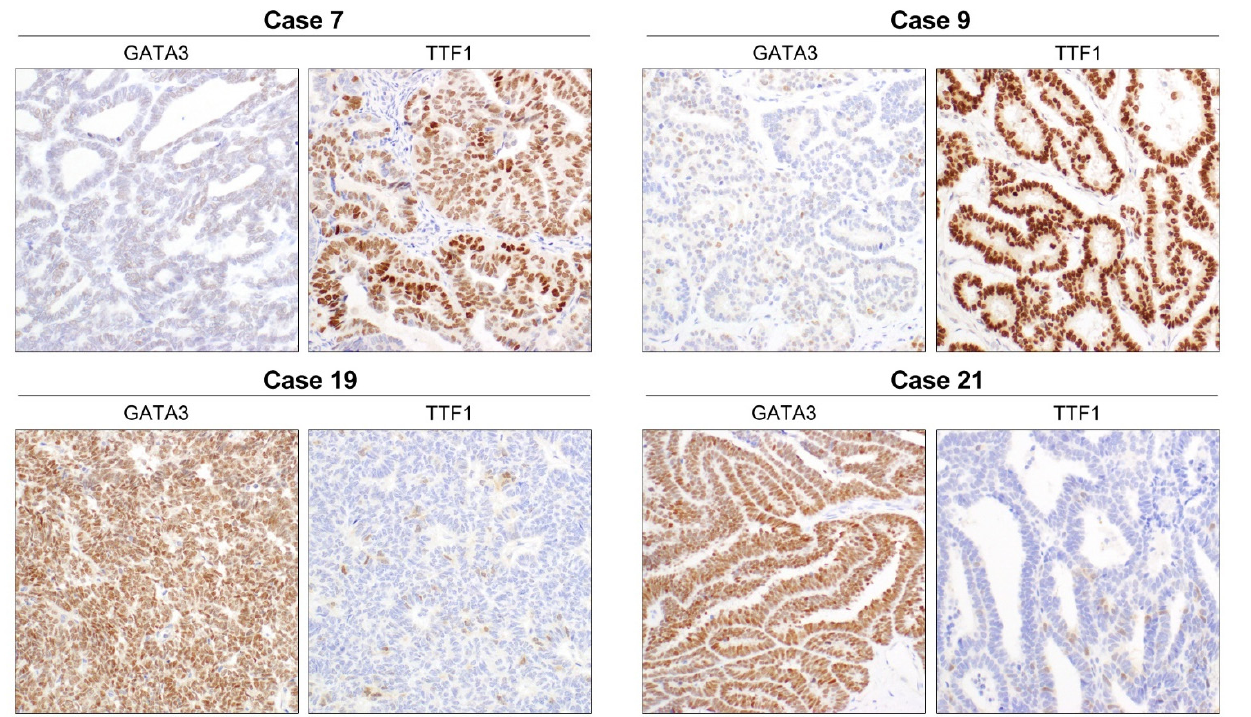
Figure 5. An inverse expression of GATA3 and TTF1. Eight of the 21 cases showed an inverse relationship between GATA3 and TTF1 expression. Four cases showing moderate-to-strong TTF1 immunoreactivity were weakly positive for GATA3 in some scattered tumor cells. In the other four cases, microscopic tumor areas that were strongly positive for GATA3 exhibited faint nuclear TTF1 expression in some tumor cells. Table 5. Associations of histo score for GATA3, ER, or PR with clinicopathological parameters, and DFS. Parameter